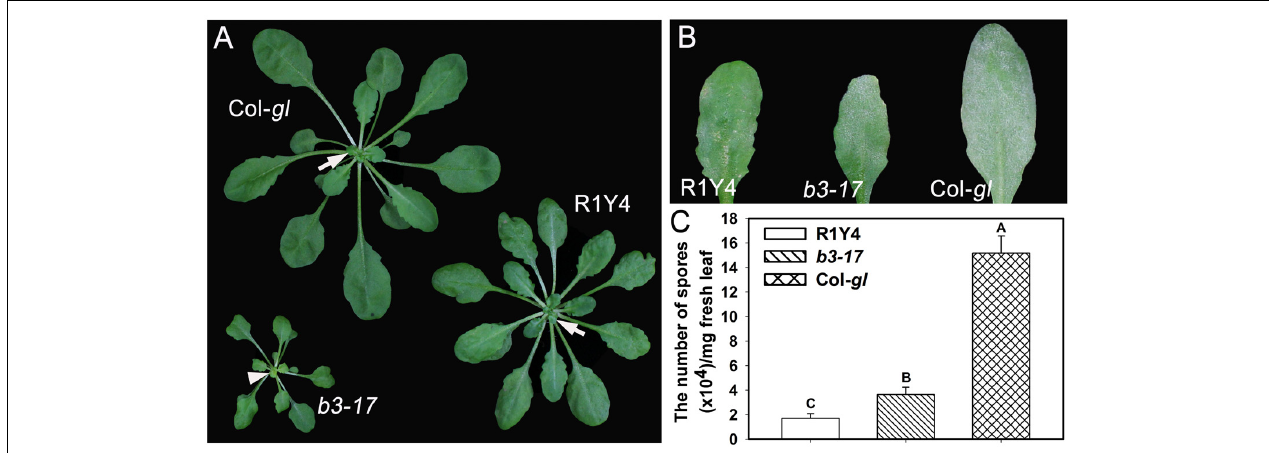
FIGURE 1 | The b3-17 mutant impairs RPW8.1 -mediated defense against powdery mildew. (A) Representative 6-week-old plants of the indicated lines show the difference in plant size. Note the freshly emerged light-green leaf (arrowhead) in the b3-17 mutant in comparison with the green ones (arrows) in R1Y4 and Col- gl . (B) Representative leaves from the indicated lines show the disease phenotype of powdery mildew at 10 days post inoculation (dpi). (C) Quantitative assay for the powdery mildew sporulation at 10 dpi. The number of spores was counted from 30 mg infected leaves for statistical analysis. Error bars represent standard deviation (SD, n = 6). Different letters above the bars indicate significant differences at P < 0.01. Similar results were obtained in three independent